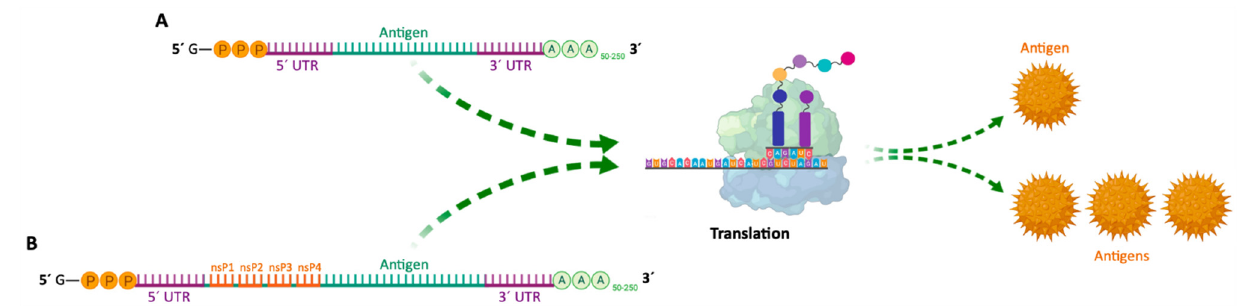
Figure 6. ( A )—Schematic structure of conventional non-amplifying mRNA vaccine. ( B )—Schematic structure of self-amplifying mRNA vaccine (replicon). UTR—Untranslated region; nsP—Non-structural proteins; A—Adenine; G—Guanine; P—Phosphate group.